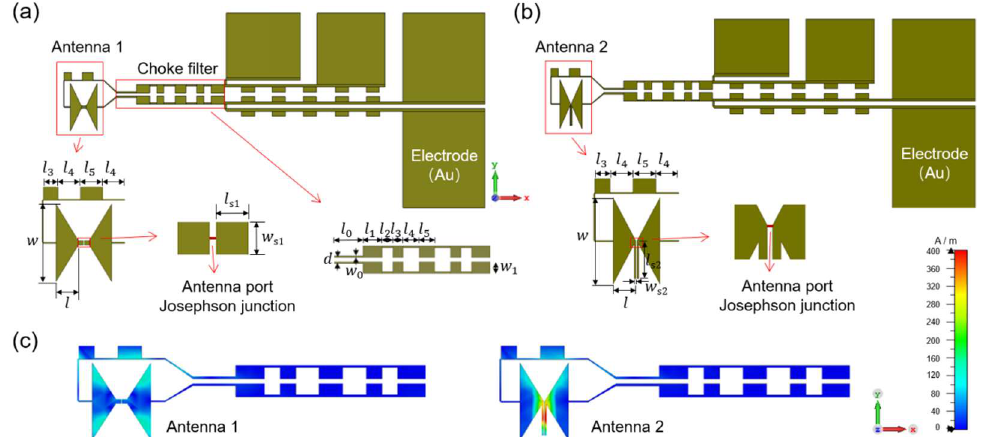
Figure 3. ( a , b ) Geometry of the on-chip layout based on YBCO bicrystal JJ THz mixer (structure parameters: l = 135 µ m, w = 515 µ m, l s1 = 30 µ m, w s1 = 30 µ m, d = 32 µ m, l 0 = 246 µ m, w 0 = 15 µ m, l 1 = 165 µ m, w 1 = 90 µ m, l 2 = l 3 = 90 µ m, l 4 = l 5 = 135 µ m), l s2 = 225 µ m, w s2 = 10 µ m. ( c ) Current distribution on the antennas and the choke filters at 0.21 THz.